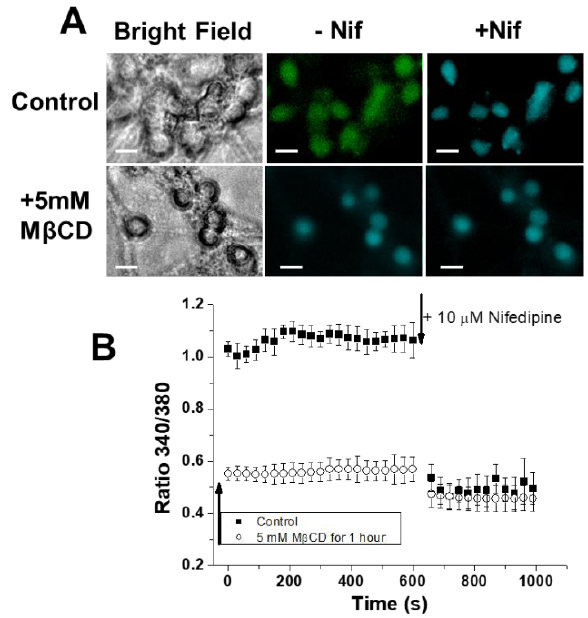
Figure 4. CGN treatment with MβCD decrease s the steady-state [Ca 2+ ] i to values close to those measured after the addition of nifedipine. ( A ) Pre- incubation and removal of MβCD– cholesterol complexes decreases the 340/380 ratio of CGNs in MLocke ’s K25 to values close to those measured after blocking LTCCs by nifedipine. Representative images of mature CGNs in culture (controls)